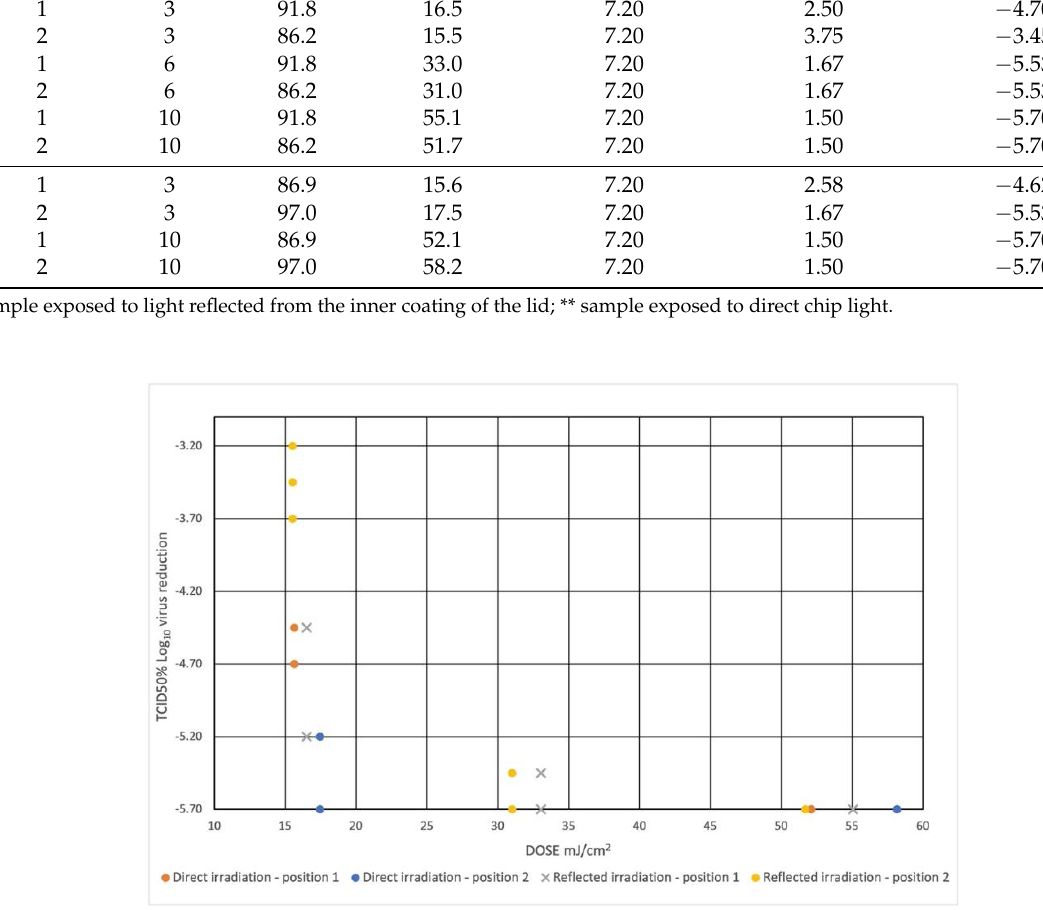
Device Con- figuration